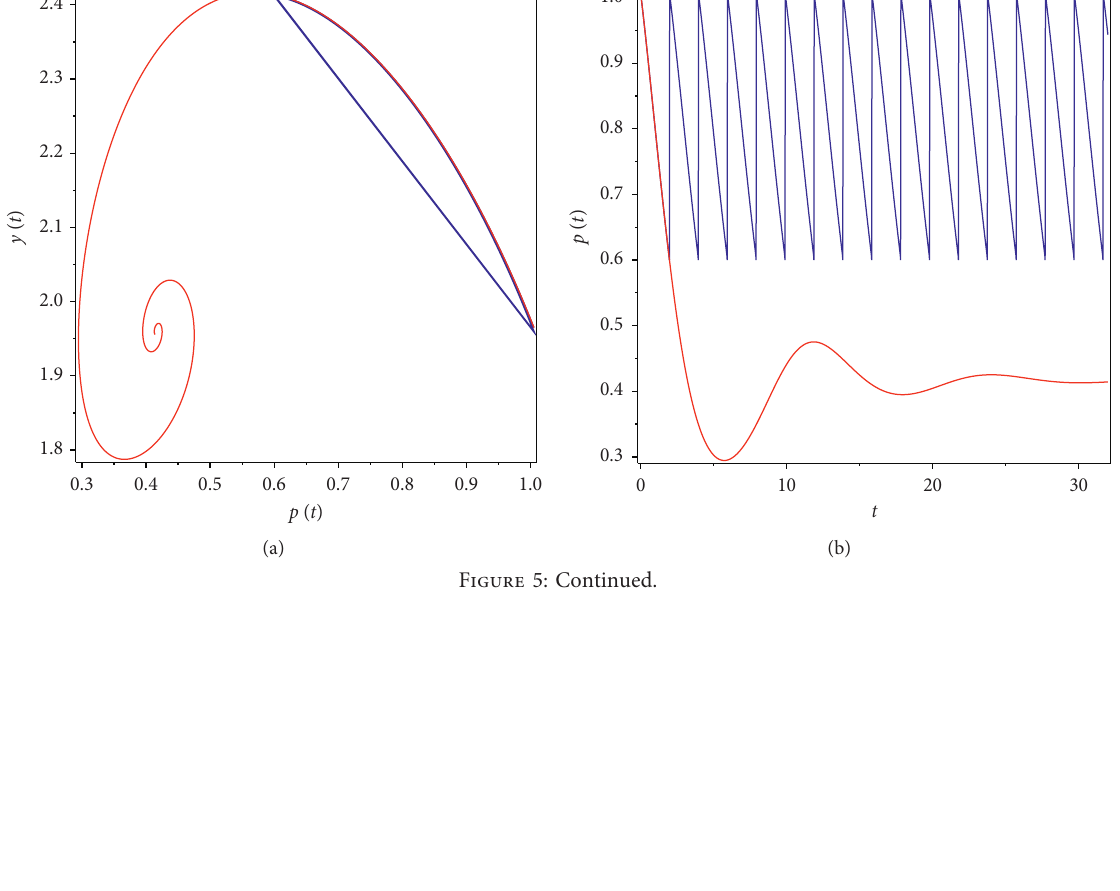
> y + > y + ≥ F M ( g A ) 1 2 0